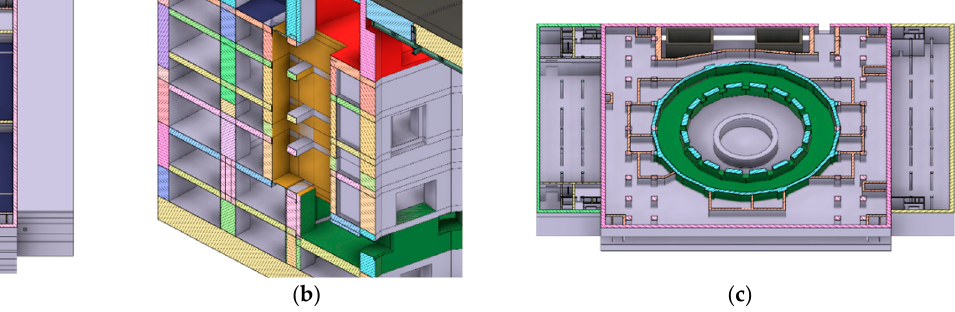
Figure 3. ( a ) Upper pipe chase (UPC) area in red and PHTS area in blue; ( b ) vertical shaft in yellow; ( c ). lower pipe chase in green.